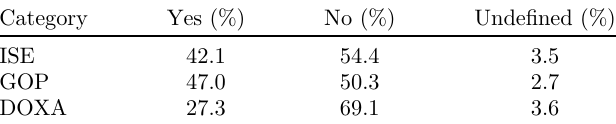
Table 9. Relationship with the sense of touch of utterances by implication in discourse, in percentage. ISE corresponds to immediate sensory experience, GOP corresponds to generaliza- tion of practices, and DOXA corresponds to doxa.